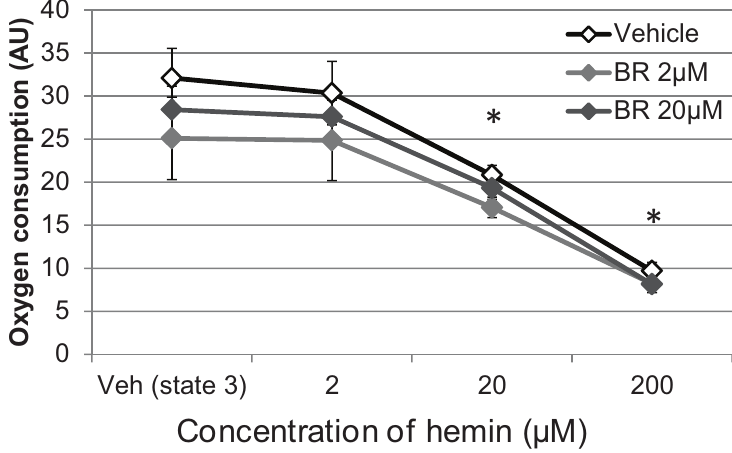
Figure 5. BR was not able to prevent hemin-mediated decrease of mitochondrial respiration. Liver mitochondria were isolated as described in the Materials and Methods section and treated with BR in the indicated concentration or with DMSO (Veh). State 3 respiration of complex II was induced by adding ADP and effects on oxygen consumption were determined after adding hemin in the indicated concentrations. Data are given as means (±SD), obtained from one experiment with n = 2 (control)/4 (BR) replicates, indicating significant differences (*) to the control (Veh state